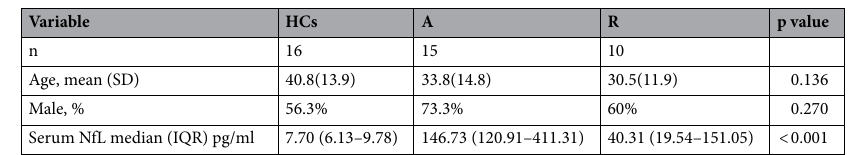
Table 2. Demographics for the study population. HCs healthy controls, A patients with MELAS in the acute attack, R patients with MELAS in the remission phase, NfL neurofilament